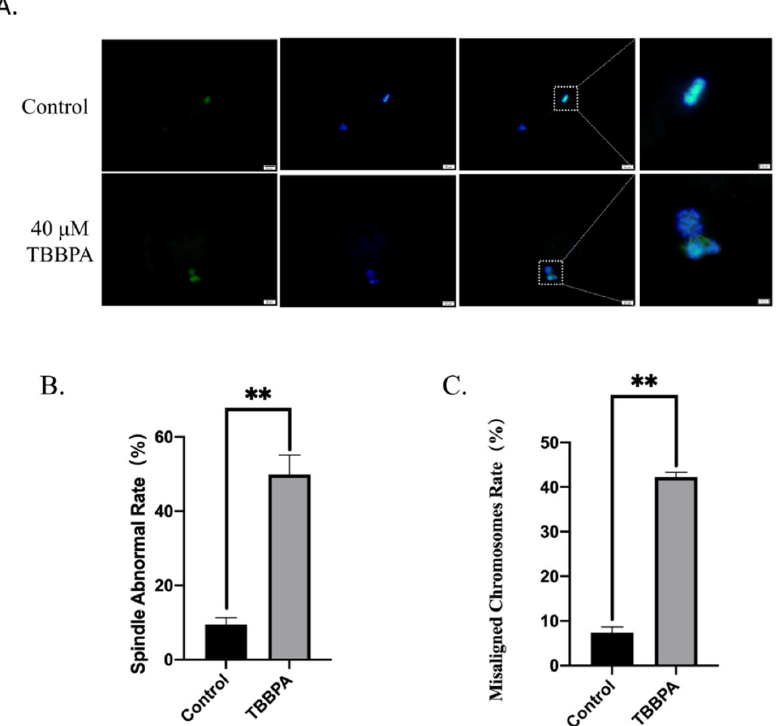
Figure 2. Effects of TBBPA on spindle/chromosome organization in oocytes: ( A ) Representative im- ages of chromosome alignment and spindle morphology after TBBPA treatment. Ex/Em, 488/530 nm; Ex/Em, 371/464 nm. Scale bar = 20 μ m. Enlarge: scale bar = 10 μ m. ( B ) Spindle abnormal rate in each group. Control, n = 50; TBBPA, n = 45. ( C ) The percentage of misaligned chromosomes was quantified. Control, n = 50; TBBPA, n = 45. ** p < 0.01.